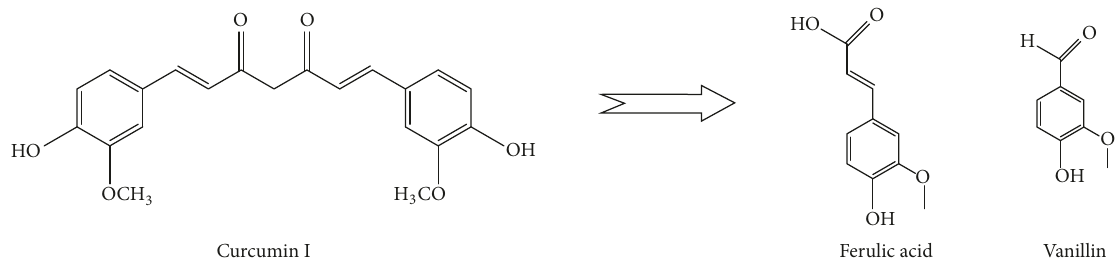
Figure 4: Diferuloylmethane’s (curcumin I) nonenzymatic degradation yielding ferulic acid and vanillin as